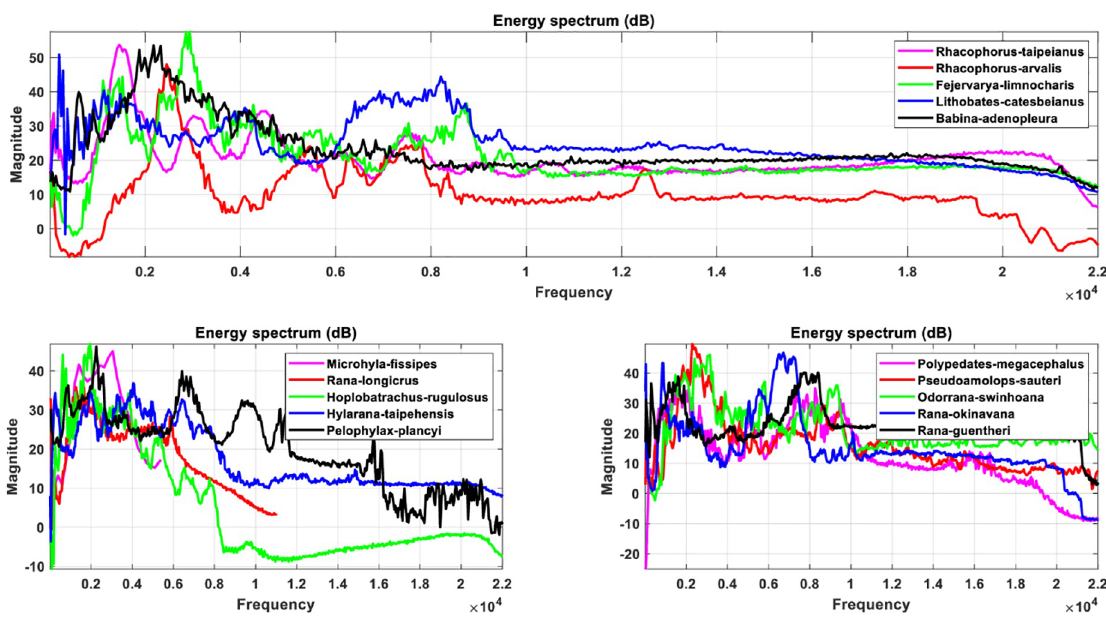
Fig 10. The spectrum diagram of anuran bioacoustic features filtered through the MFCC algorithm with pre-emphasis coefficient equal to 0.9, including Rhacophorus taipeianus , Rhacophorus arvalis , Fejervarya limnocharis , Lithobates catesbeianus , Babina adenopleura , Microhyla ornata , Rana longicrus , Hoplobatrachus rugulosus , Hylarana taipehensis , Pelophylax plancyi , Polypedates megacephalus , Pseudoamolops sauteri , Odorrana swinhoana , Rana okinavana and Rana guentheri .